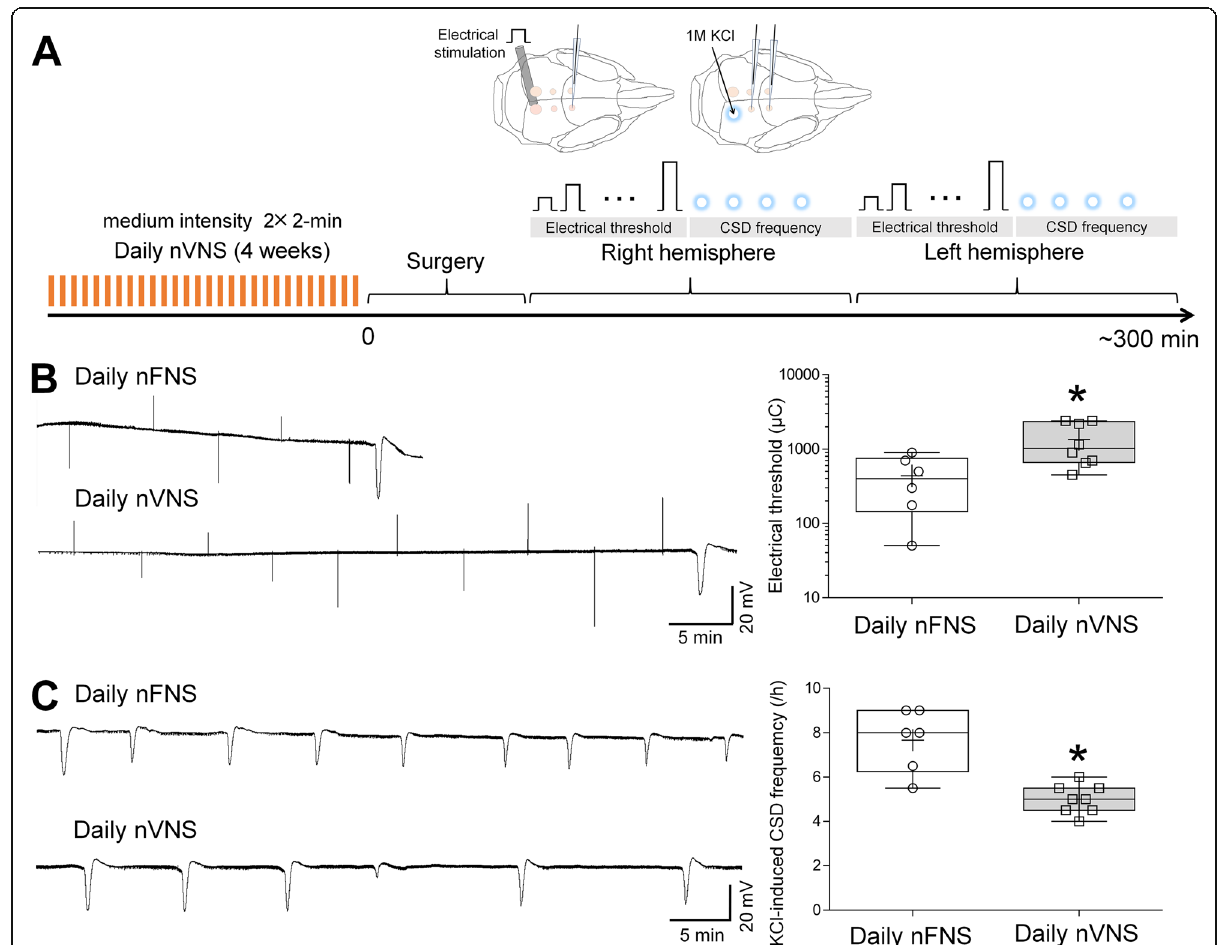
Fig. 3 Chronic daily nVNS exerts comparable efficacy to acute treatment. A Schematic diagram of chronic daily noninvasive transcutaneous VNS paradigm. A Bar indicates 2 × 2-minute stimulation ( B-C ) Representative intra-cortical microelectrode recordings and whisker – box plots show the effects of noninvasive femoral nerve stimulation (nFNS) or noninvasive transcutaneous VNS (2 × 2-minute, 11.4 V) on electrical threshold ( B ) and KCl (1 M)-evoked CSD frequency ( C ) in rats. Whisker – box plots show that chronic daily nVNS significantly elevates electrical threshold and inhibits KCl-evoked CSD frequency in rats (whisker: full range; line: median; cross: mean; * P =0.0184 for electrical threshold, * P= 0.0039 for CSD frequency, compared to daily nFNS group, n =6 for nFNS and n =8 for nVNS, unpaired-t-test with Welch ’ s correction), which is comparable to